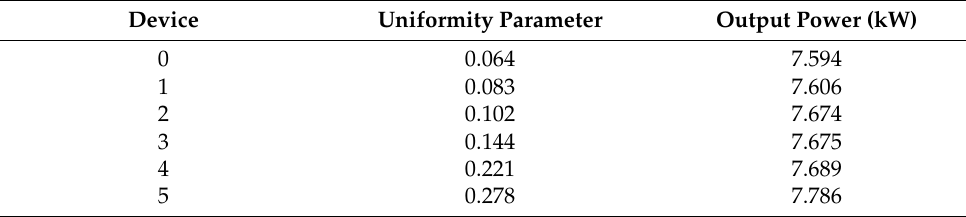
Table 2. Specific Parameter for the results of uniformity parameter and output power.